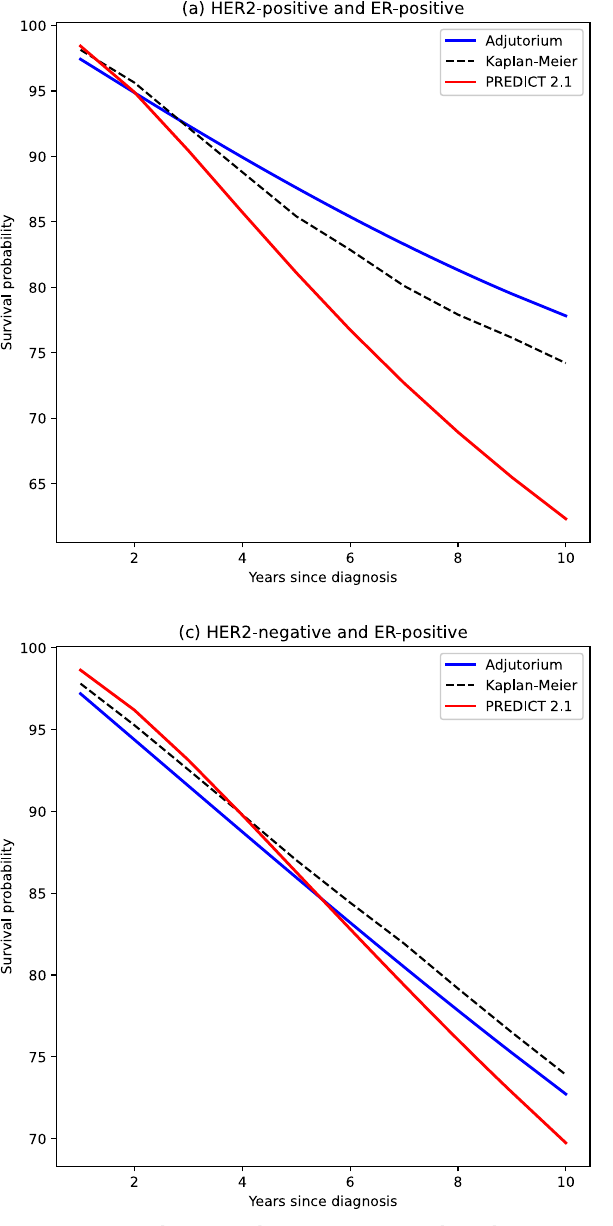
Fig. 2 Comparison between the average survival predictions issued by Adjutorium and PREDICT in different breast cancer subtypes. a – d The predicted survival curves by the two models for patients with HER2-positive/ER-positive, HER2-positive/ER-negative, HER2-negative/ ER-positive and HER2-negative/ER-negative, respectively. The survival curve predicted by Adjutorium is colored in blue, whereas the survival curve issued by PREDICT is colored in red. The empirical Kaplan – Meier survival curves are depicted through the dashed black lines. These evaluations were conducted using the NCRAS registry